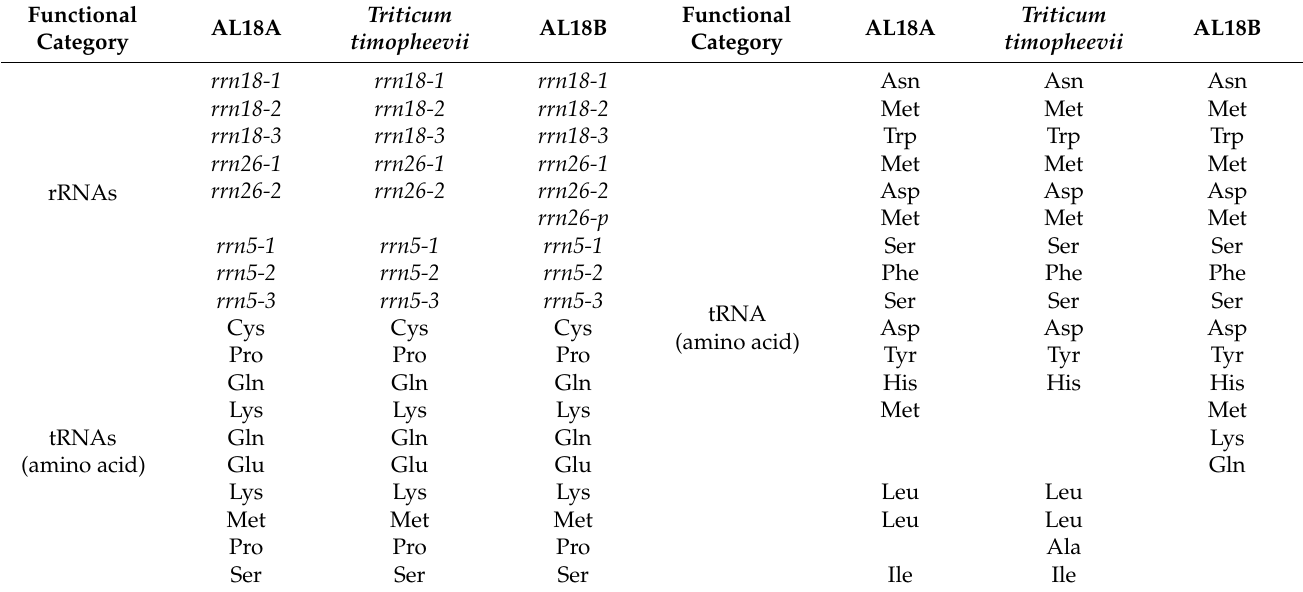
Table 4. Comparison of noncoding genes in different mitochondrial